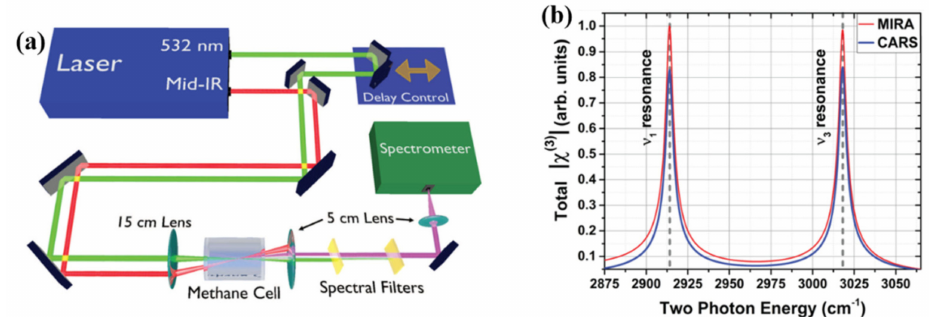
Figure 11. ( a ) The optical path of CARS nonlinear optical system based on MIRA. ( b ) χ ( 3 ) as a detuning function of MIRA and CARS [56]. Republished with permission from Ref. [56]. Copyright 2022 American Physical